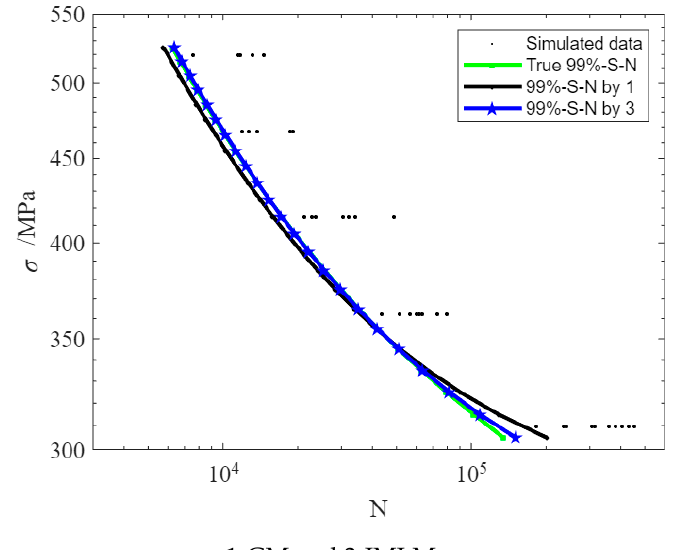
Figure 8. Sample arrangement and 99%-S-N curve obtained by two methods.